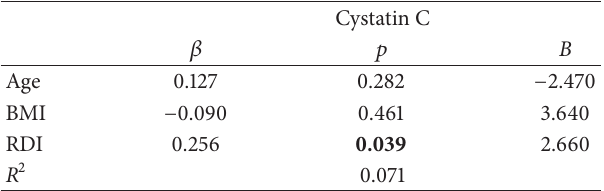
Table 5: Multiple regression analysis results in a model examining the predictive role of age, BMI, and RDI on serum cystatin C levels in OSAS